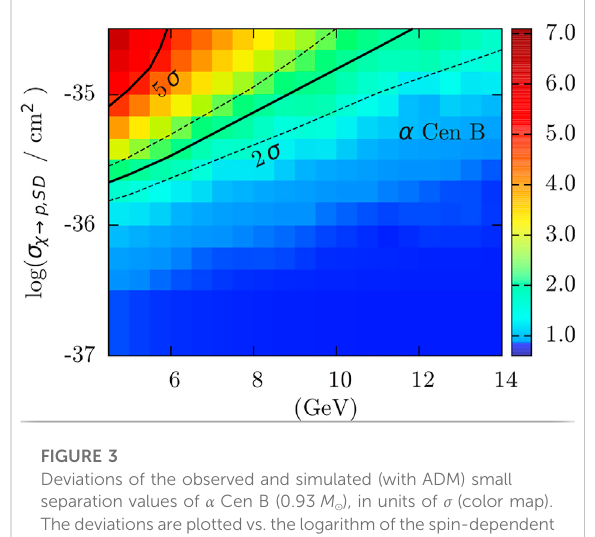
FIGURE 3 Deviations of the observed and simulated (with ADM) small separation values of α Cen B (0.93 M ⊙ ), in units of σ (color map). The deviations are plotted vs. thelogarithm ofthe spin-dependent cross sections ( log ( σ χ → p ) ) , and masses in GeV, two parameters of the asymmetric dark matter. The solid black line shows the two σ region. The dashed lines around the solid black one indicate the observational errors. Taken by Casanellas and Lopes